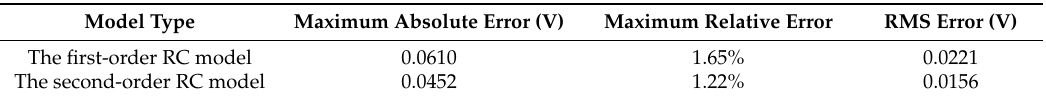
Table 4. The output error of the first-order and the second-order model for 1C constant current discharging. Root mean square (RMS): root mean square.